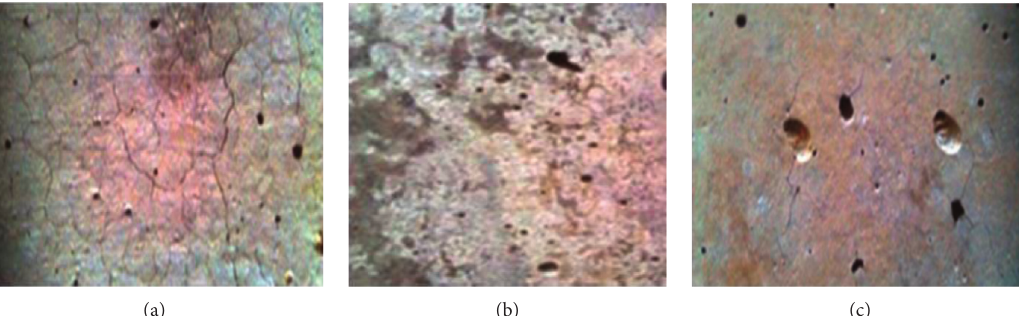
2 O 3 nanoparticles, and (c) sample